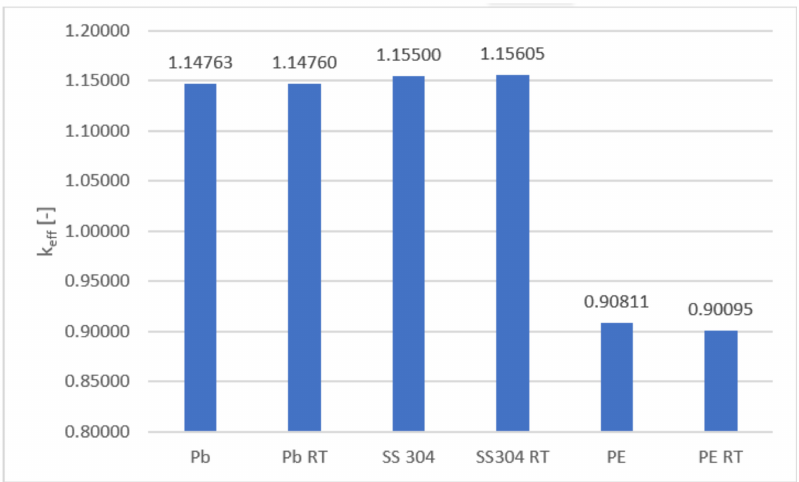
Figure 7. Scoping analysis of the effect of the operational temperature (800 K versus room tempera- ture, RT) of the 30 cm thick reflector using metal-based as well as hydrogen-based materials on the criticality of the studied 2D test core.